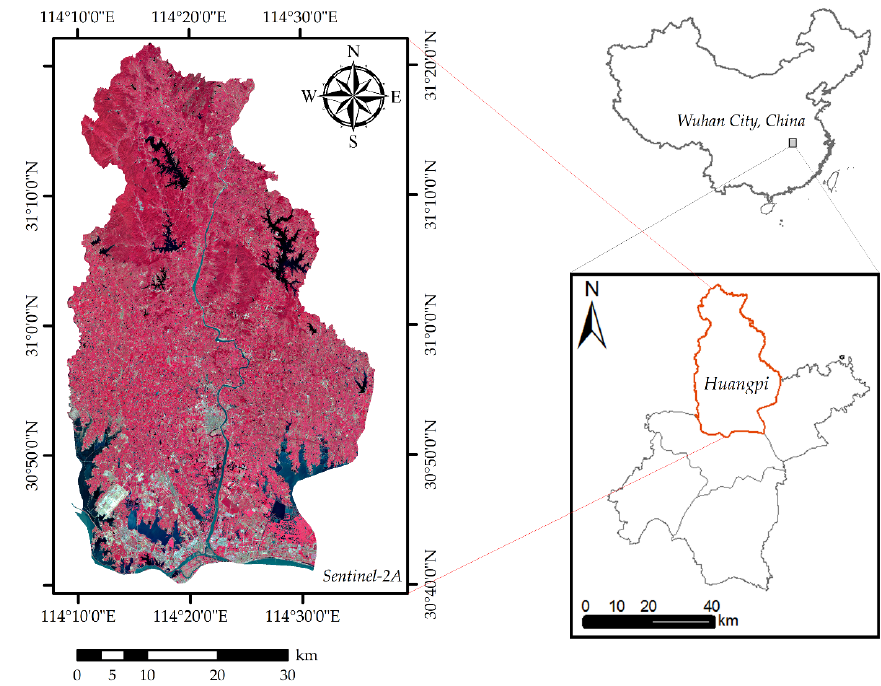
Figure 1. Overview of our study area. The false color image consists (left) of the near-infrared, red and green bands of Sentinel-2A. The red boundary (Huangpi district) in the bottom-right corner is the study area in Wuhan, and the top-right image is the scaled map of China.